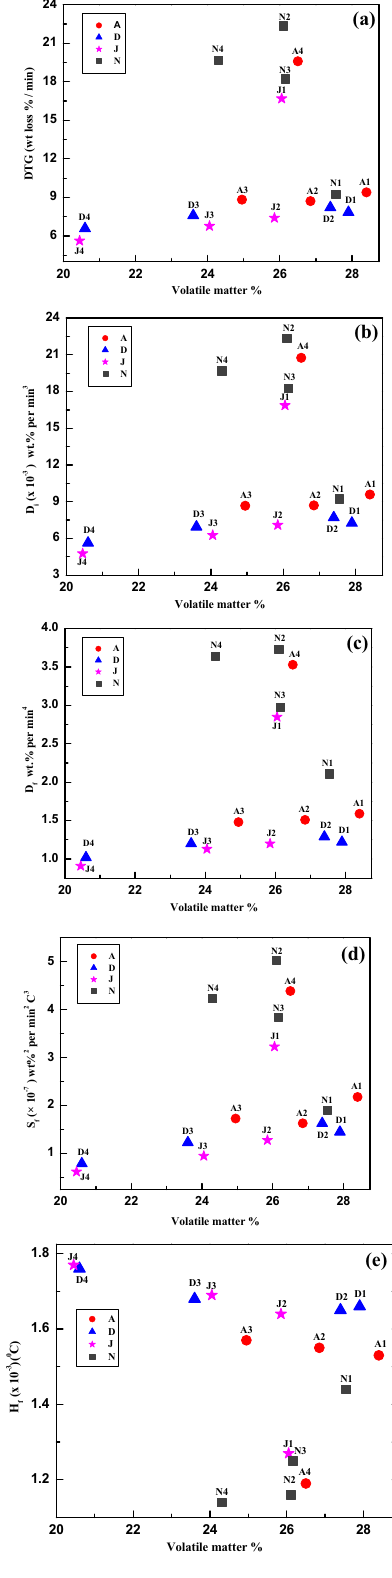
Fig. 3 Variation of combustion parameters: a DTG max , b D i , c D f , d S f , e H f with volatile matter % for all the